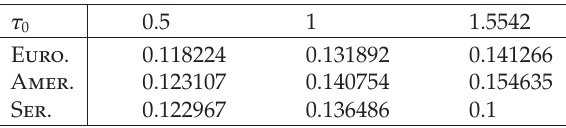
= 1 . 0, E = 1 . 0, r = 0 . 1, 0